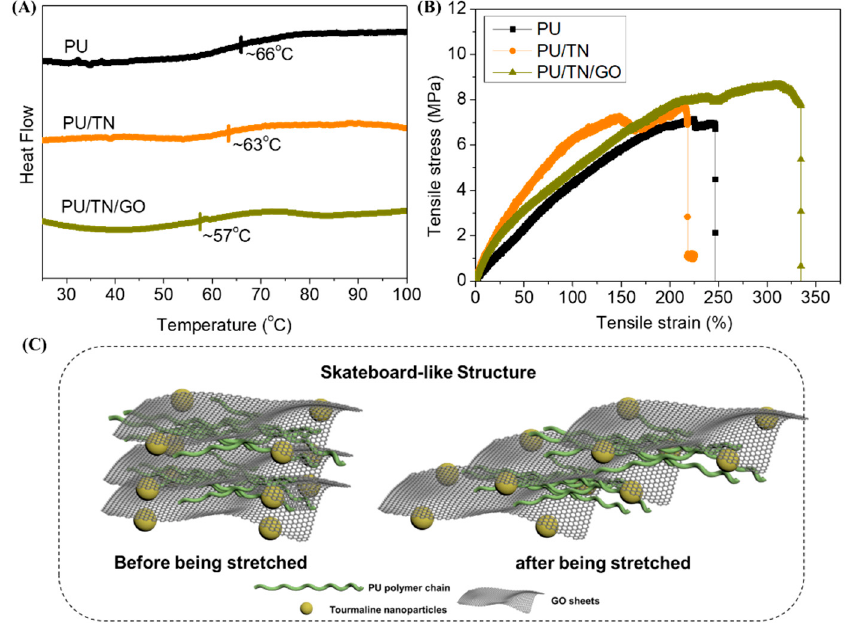
Figure 5. Thermal ( A ) and mechanical properties ( B ) of PU and its nanocomposite fibers and ( C ) skateboard-like structure of PU/TN/GO before and after being stretched. Table 1. Mechanical properties of PU and its nanocomposite fibers.